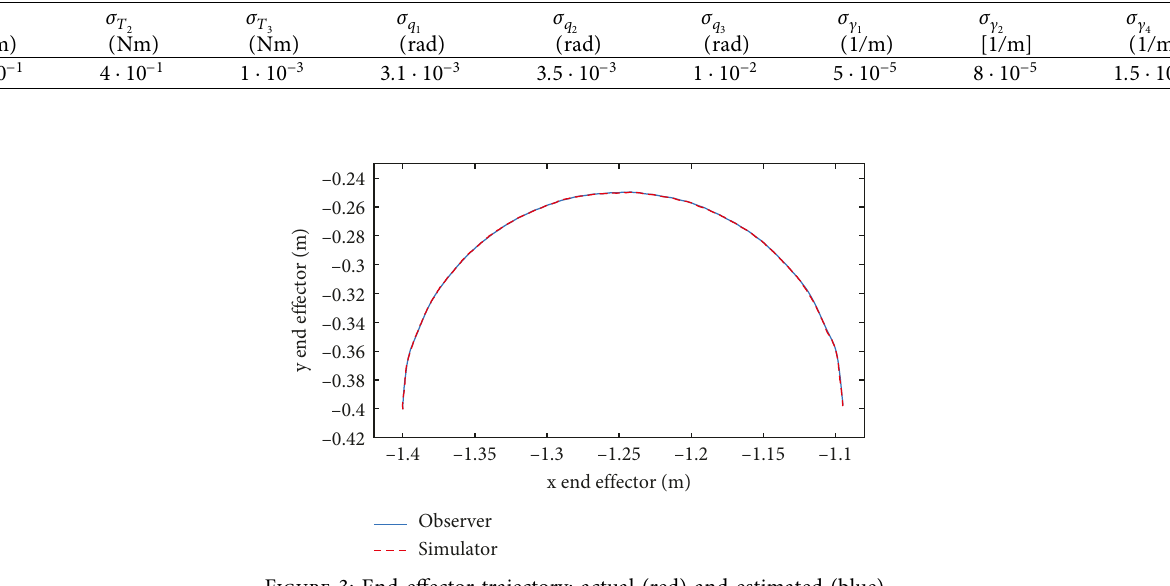
Figure 3: End-effector trajectory: actual (red) and estimated (blue).